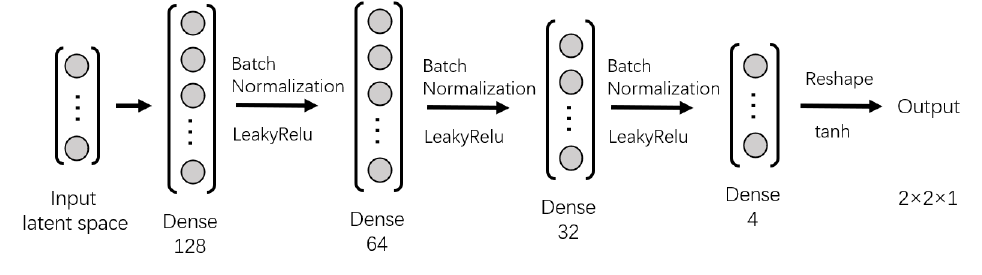
Figure 14. The structure of the generator for the eye